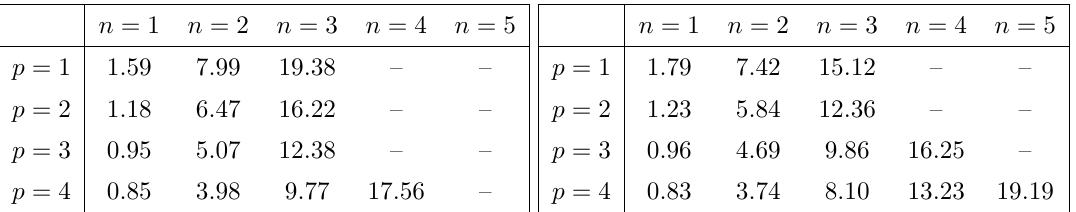
with the usual potential L 0246